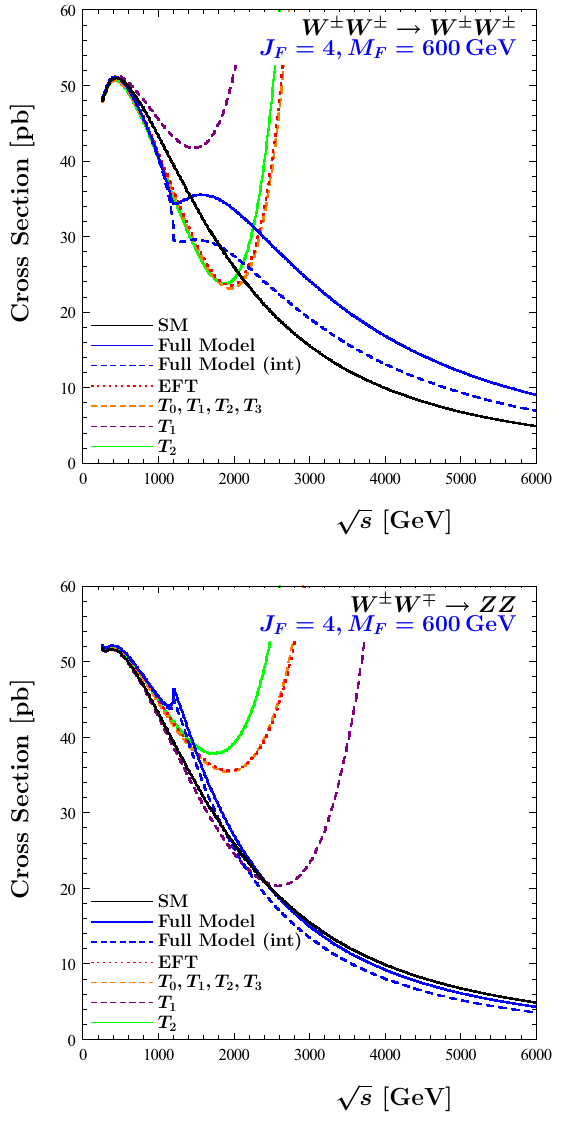
representseveralEFTapproximations,uptodimension-8operators(see textfordetails).The“fullmodel”withfullfermion1-loopcontributions is represented by the solid blue line while “full model (int)” (dashed blue) includes the interference term in Eq.(43) only. The solid black line represents the SM expectation, in the g (cid:5) = 0 limit